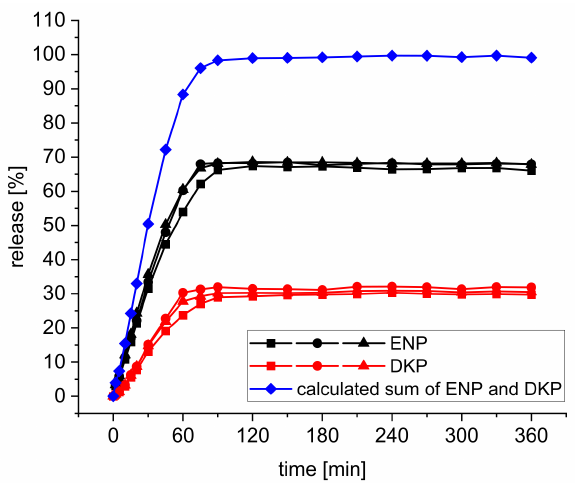
Figure 9. In vitro dissolution profiles of ENP and DKP from bPMMA tablets (n = 3), as well as the calculated sum of ENP and DKP, pH 1.2 buffer solution, USP Apparatus 1-basket, 37 ◦ C, 50